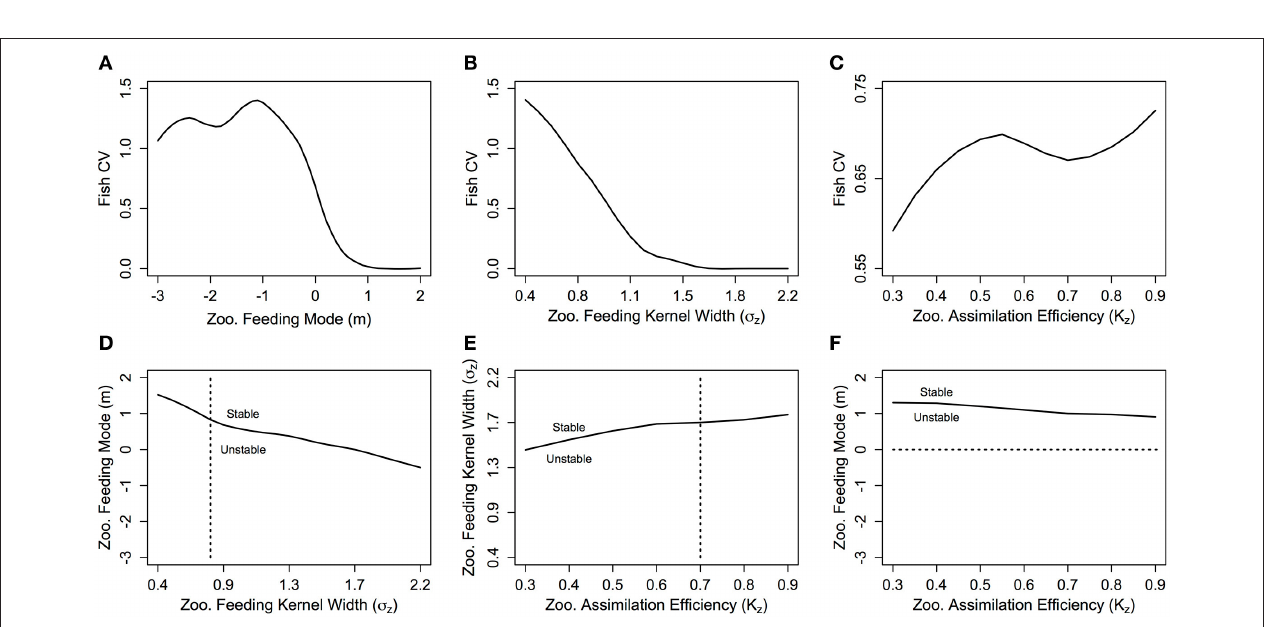
0, σ z 0.75 and K z = = =